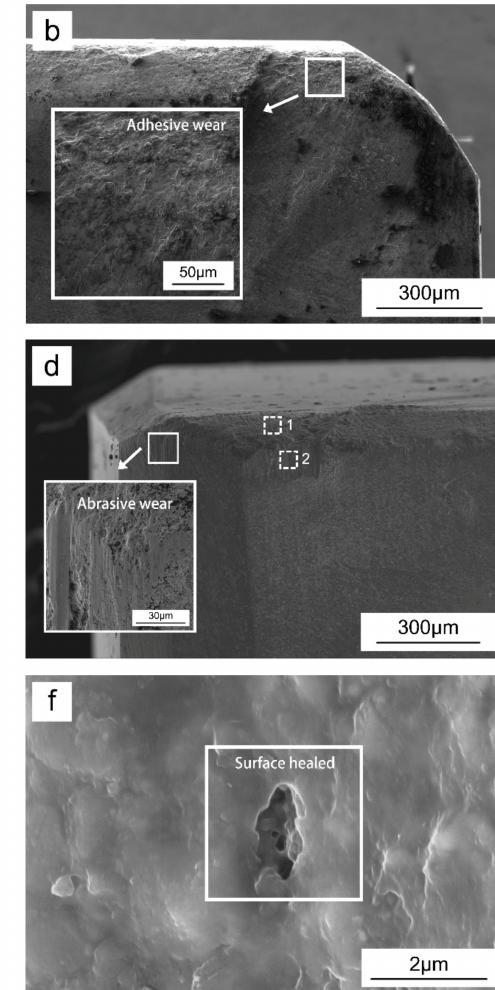
Figure 8. Wear morphology and partial enlargement of the flank of two kinds of ceramic tools ( a , c ) AT ( b , d – f )